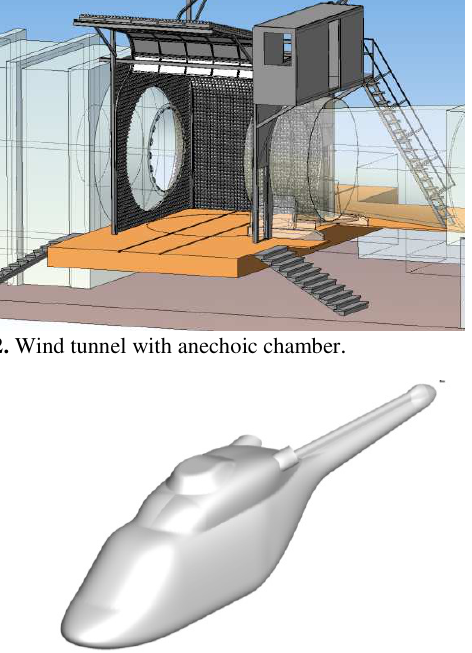
Fig. 3. The isolated fuselage model .